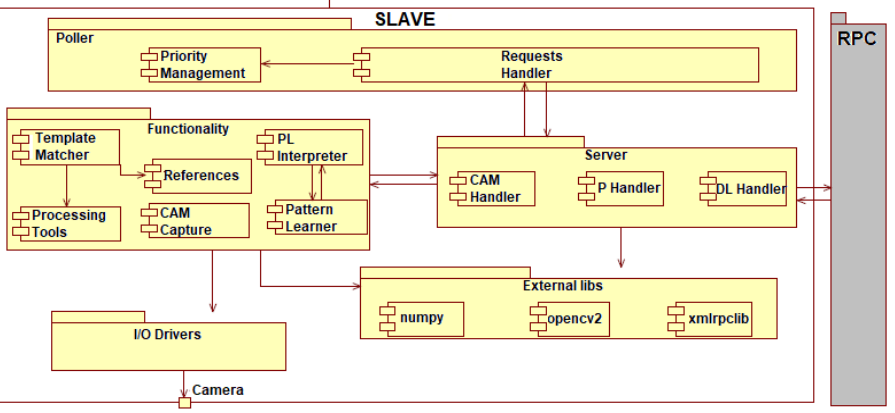
Figure 8. Software architecture of the Slave node.